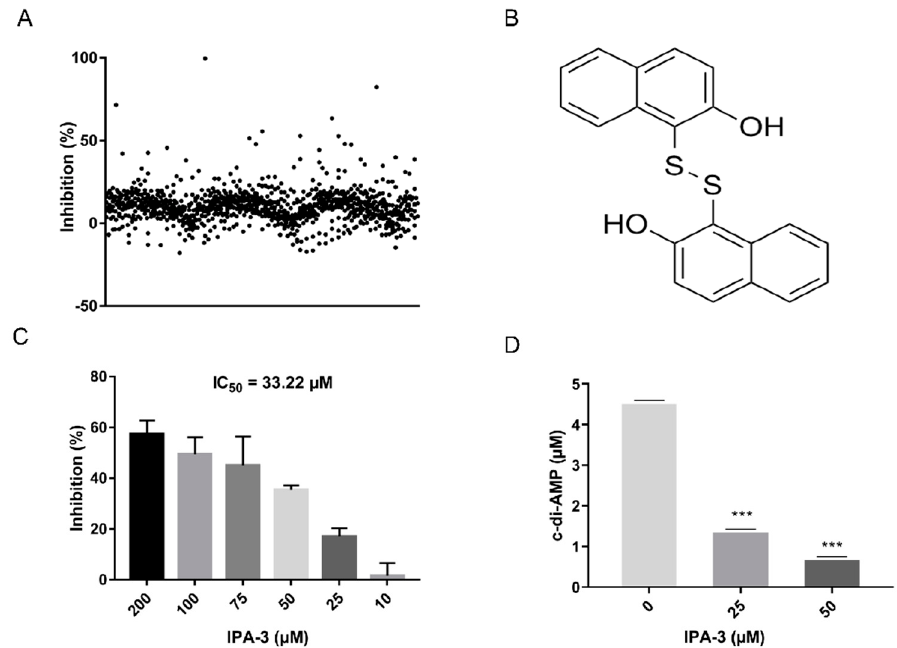
Figure 3. Screening for ssDacA inhibitors. ( A ) The scatter plot of the primary screening with the 1133 compounds; ( B ) the structure of IPA-3; ( C ) determination of IC 50 of IPA-3 against ssDacA. Reactions containing 100 µ M of ssDacA and varied concentrations of IPA-3 (10, 25, 50, 75, 100, 200 µ M), were performed and the IC 50 was calculated using the variable-slope 4-parameter model. The data presented are the means ± standard errors of the mean ( n = 3). ( D ) Inhibition of IPA-3 on the production of c-di-AMP. Reactions containing 50 µ M of ssDacA and varied concentrations of IPA-3 (0, 25, 50 µ M) were performed in vitro. The produced c-di-AMP was quantified by HPLC. The data presented are the means ± standard errors of the means ( n = 3). *** represents p value < 0.001.